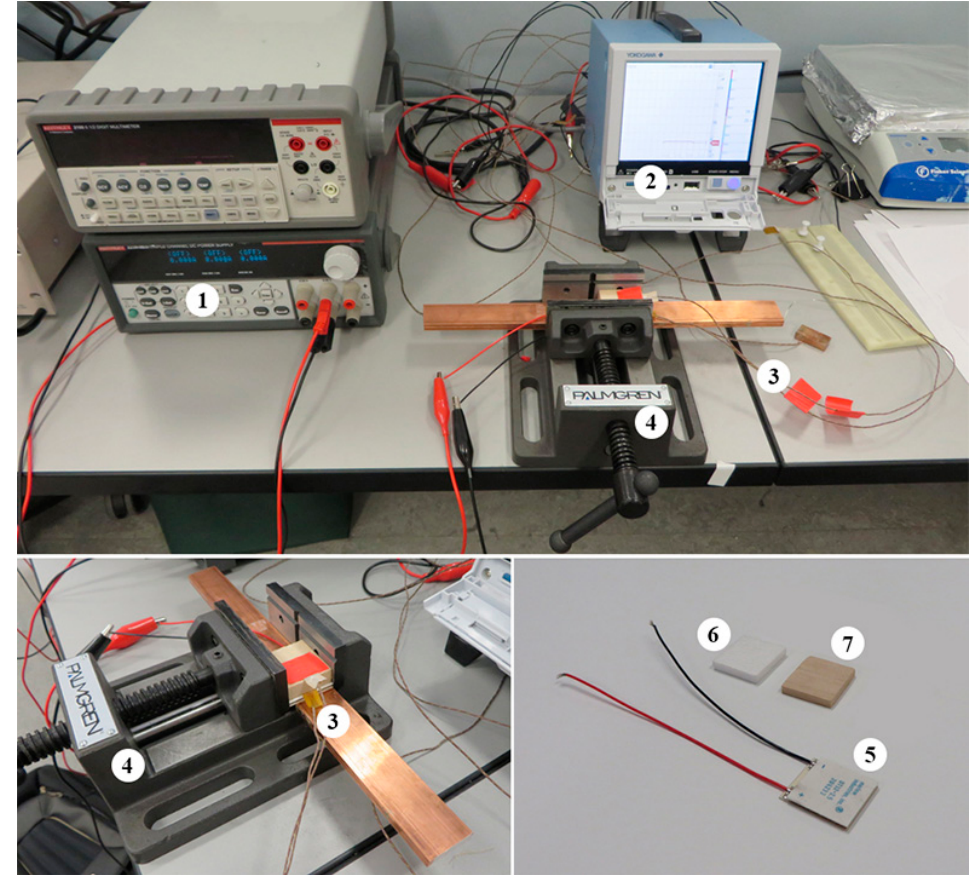
Figure 4. Thermal conductivity test assembly and equipment: 1—Power supply (Keithley 2230), 2— Datalogger (Yokogawa G10), 3—Thermocouple (Type K), 4—Bench vise (Palmgren), 5—Thermoelectric cooler (Marlow Industries DT12-2.5), 6—EPS sample (Knauf Isopor ® ), and 7—Buriti foam sample.